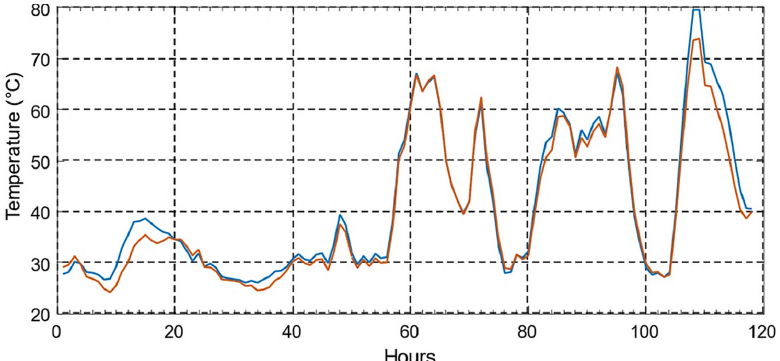
Figure 44. Oil temperature at the top of the transformer through simulated (blue) and measured (orange) ambient temperature for August.